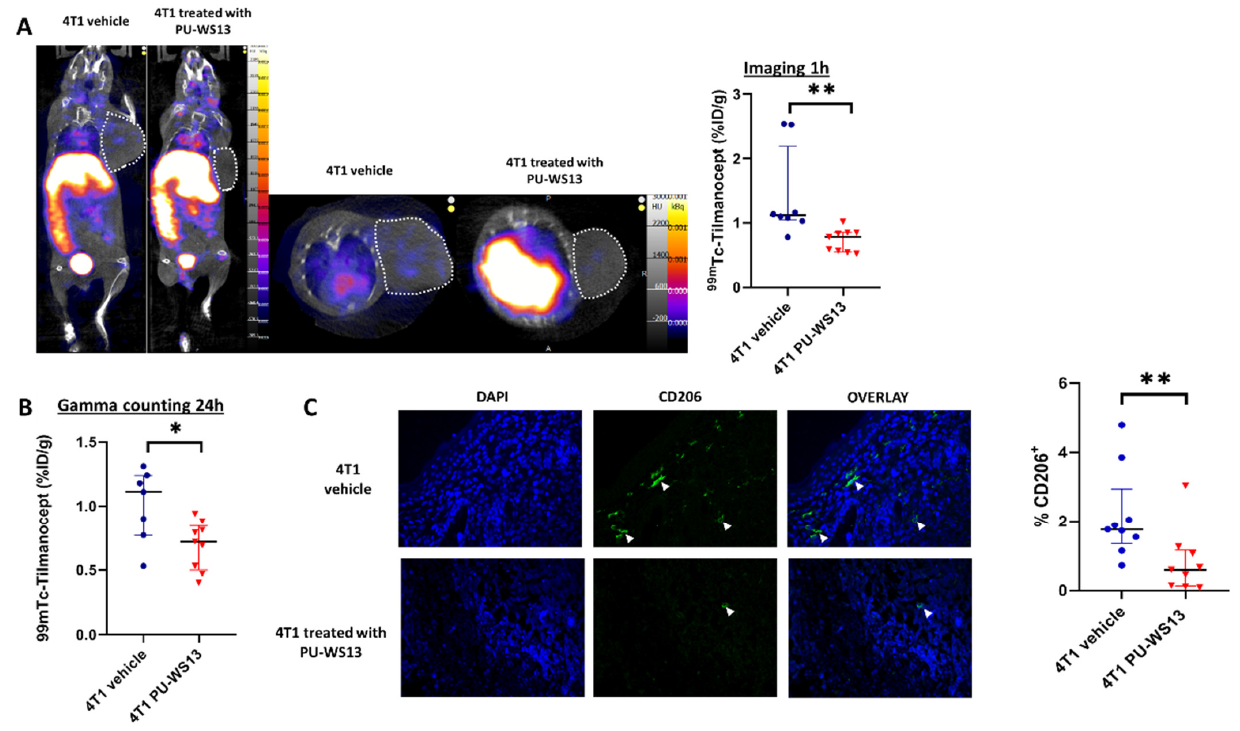
Figure 3. GRP94 inhibition by PU-WS13 induces a decrease in 99m Tc-Tilmanocept tumor uptake in vivo. ( A ). Representative SPECT/CT images of 4T1 tumor-bearing mice receiving vehicle ( n = 8) or PU-WS13 ( n = 9) from D11 up to D22 at 1 h post-injection of 15 MBq/100 µ L of 99m Tc-Tilmanocept. Tumors are highlighted with circles. The scatter dot plot represents the percentage of the injected dose of 99m Tc-Tilmanocept per gram of tumor (%ID/g) for both groups. Results are presented as the median with the interquartile range, ** p = 0.0011. ( B ). The scatter dot plot represents the percentage of injected dose of 99m Tc-Tilmanocept per gram of tumor of 4T1 tumor-bearing mice receiving vehicle ( n = 8) or PU-WS13 ( n = 9) from D11 up to D22 at 1 h post-injection of 15 MBq/100 µ L of 99m Tc-Tilmanocept measured by gamma counting. Results are presented as the median with the interquartile range. * p = 0.0328. ( C ). Representative images (vehicle n = 9, PU-WS13 n = 9) and quantification of CD206 staining in 4T1 tumors from mice treated or not with PU-WS13 from D11 up to D22. Results are presented as the median with the interquartile range. ** p = 0.0056.